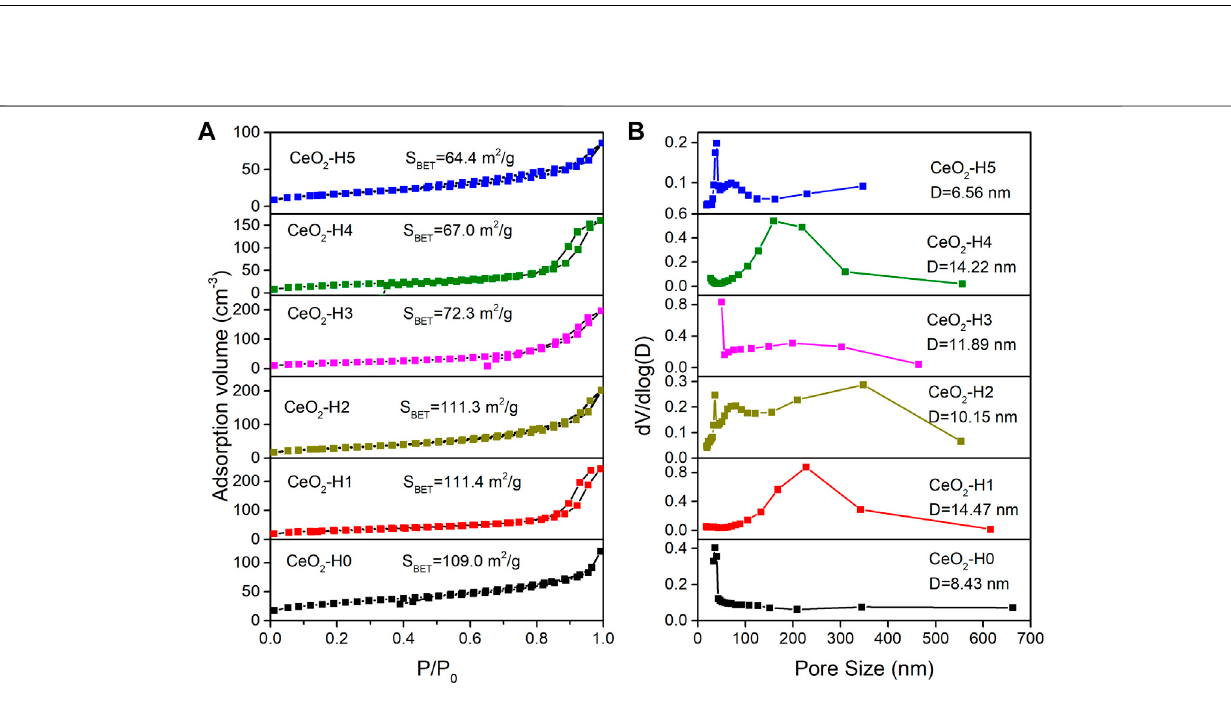
Frontiers in Chemistry |